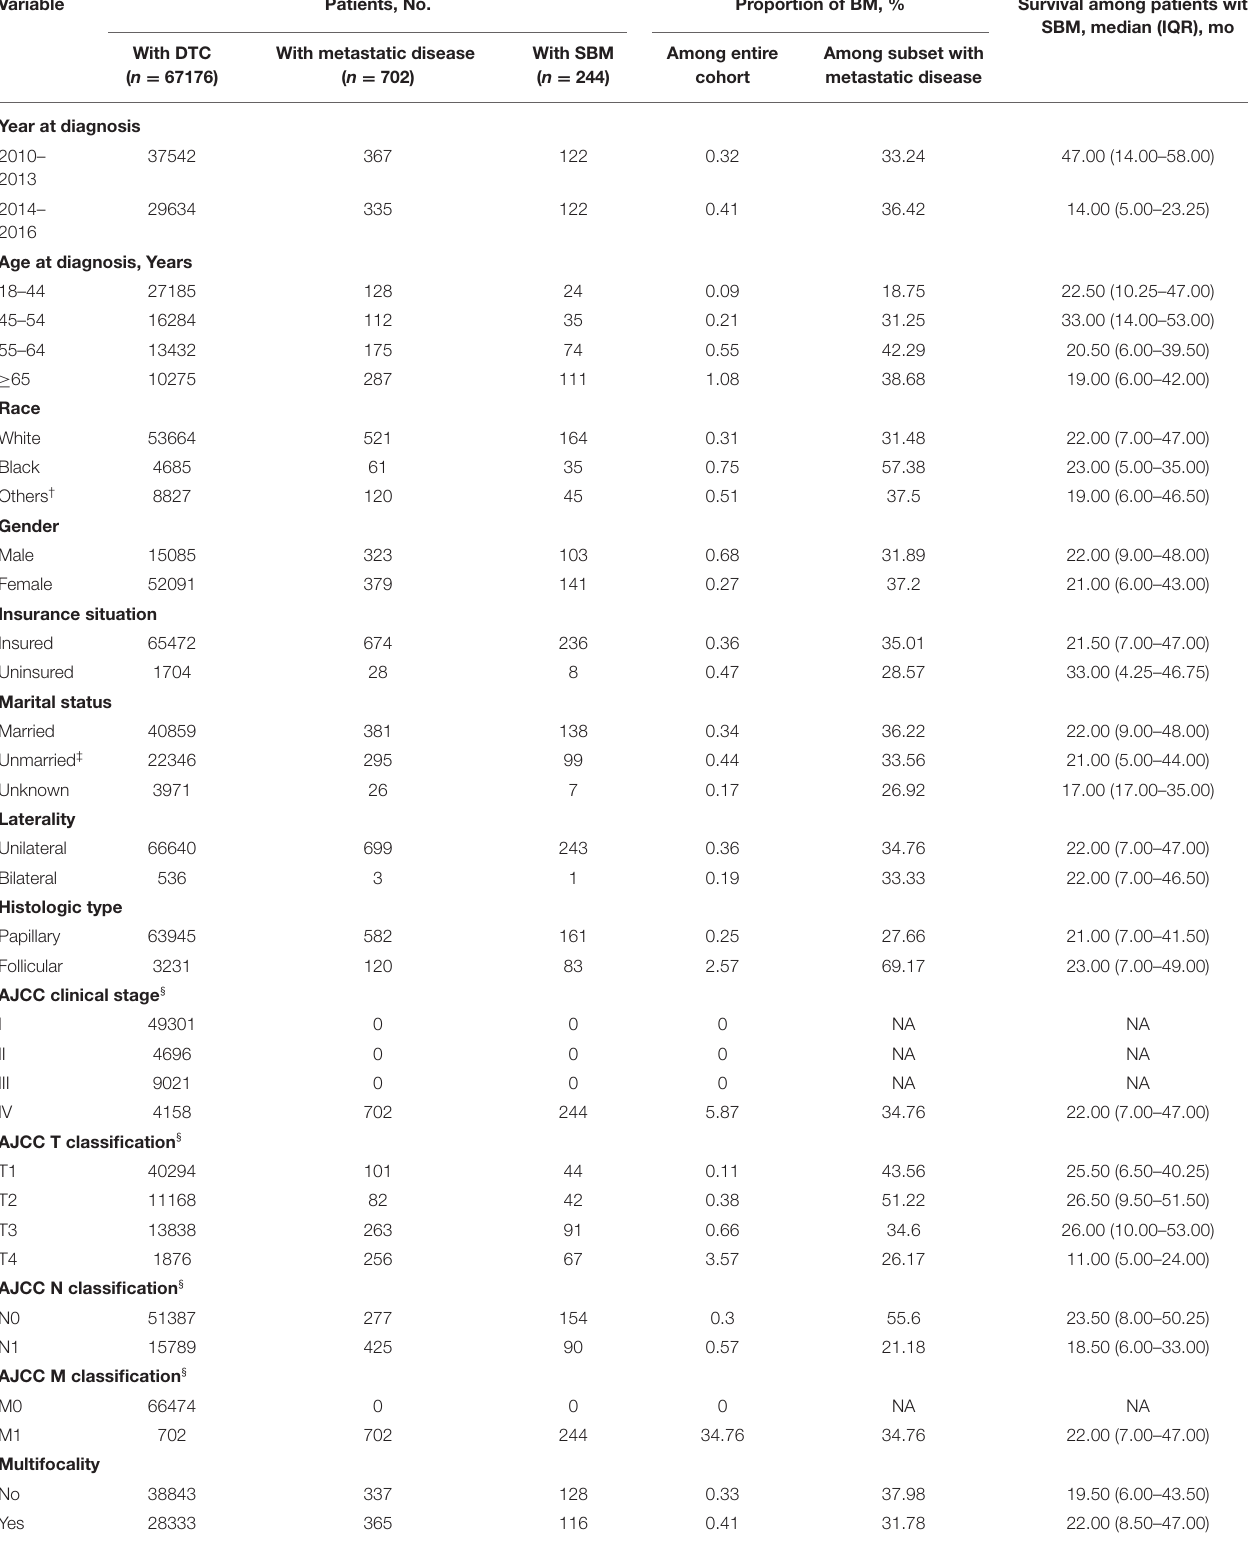
TABLE 1 | Demographic and clinical characteristics of DTC patients with SBM. Variable Patients, No. Proportion of BM, % Survival among patients with SBM, median (IQR), mo With DTC With metastatic disease With SBM Among entire Among subset with ( n = 67176) ( n = 702) ( n = 244) cohort metastatic